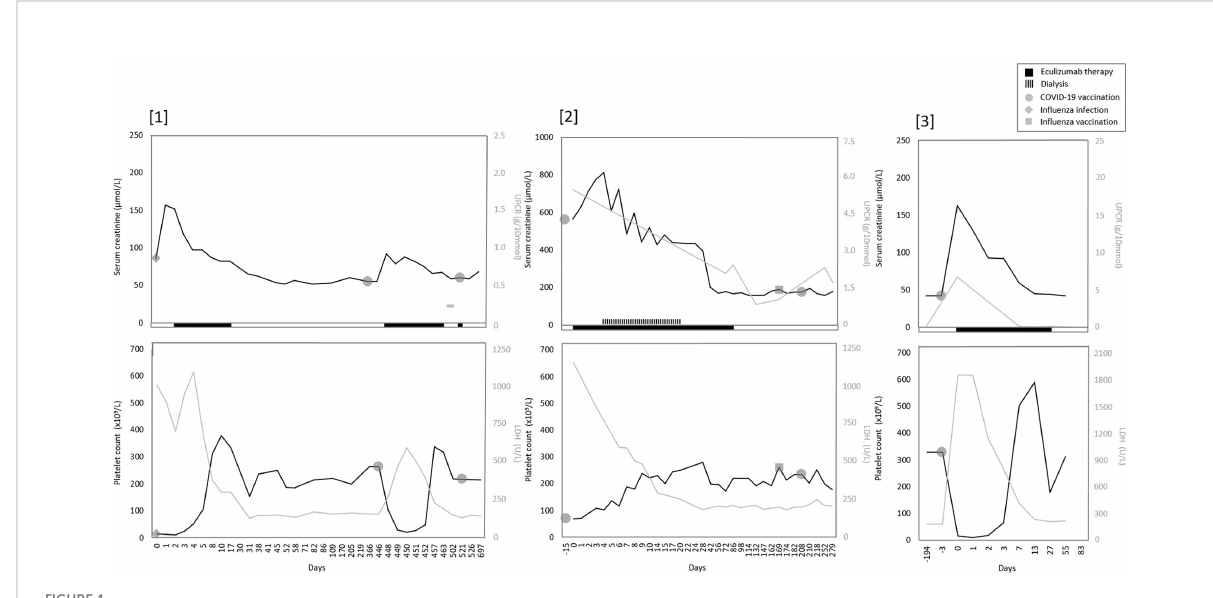
FIGURE 1 Overview of serum creatinine, proteinuria, and TMA parameters over time in all patients. Overview trend of serum creatinine, proteinuria and TMA parameters LDH and thrombocytes (platelet count). [1] Only one measurement of UPCR was available in patient one. Before the second COVID-19 vaccination, a prophylactic dose of eculizumab was